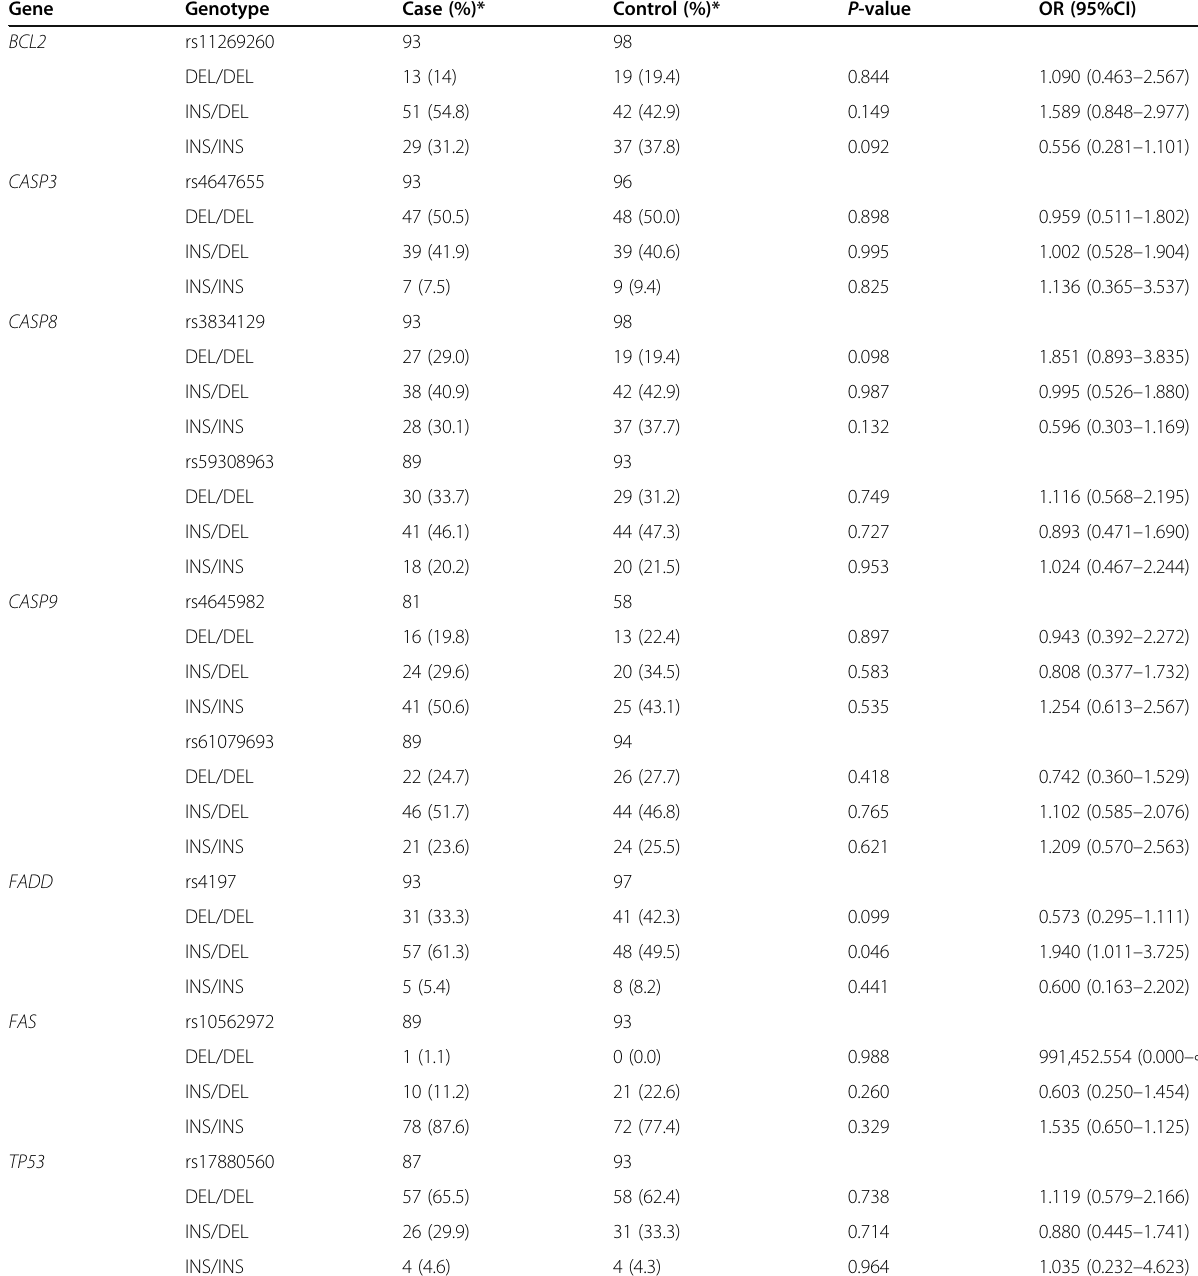
Table 3 Genotypic distribution of the investigated variants for patients with GC in comparison to control group. P -value, OR and 95%CI were obtained with logistic regression adjusted for age, which was done for the genotype as reference in each line (DEL/DEL vs. the other genotypes of that marker, and the same for INS/DEL and